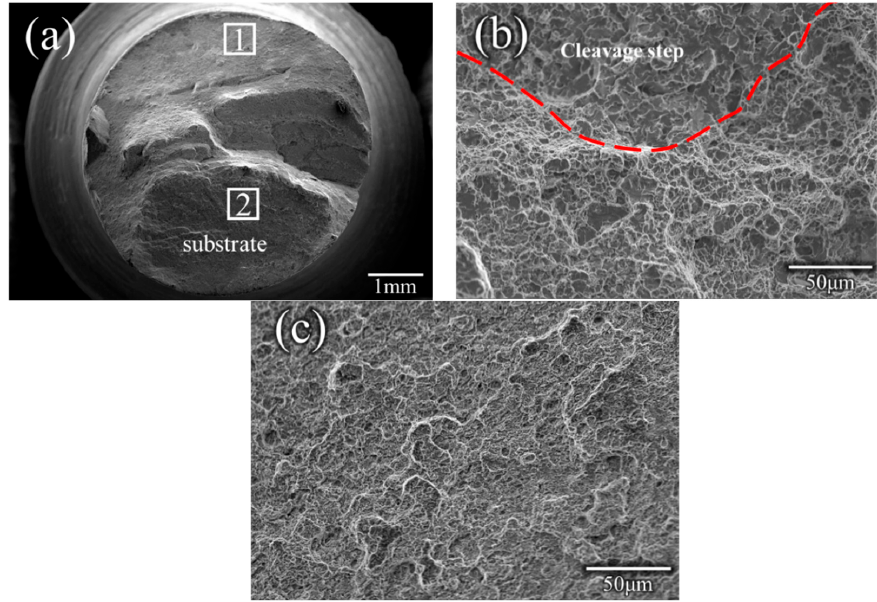
Figure 10. Image of the fracture position in the tensile specimens.